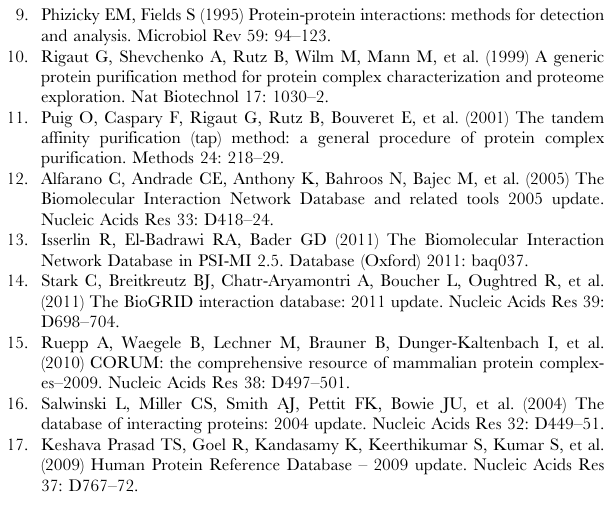
Figure S1 Two procedures used by ppiTrim for com- plex deflation. Table S1 Top ten publications according to the number of reported complexes. Table S2 Top 25 most frequent Yeast protein members of complexes. Table S3 Top 25 most abundant Human protein members of complexes. Table S4 Yeast components containing 10 or more nodes. Table S5 Human components containing 10 or more